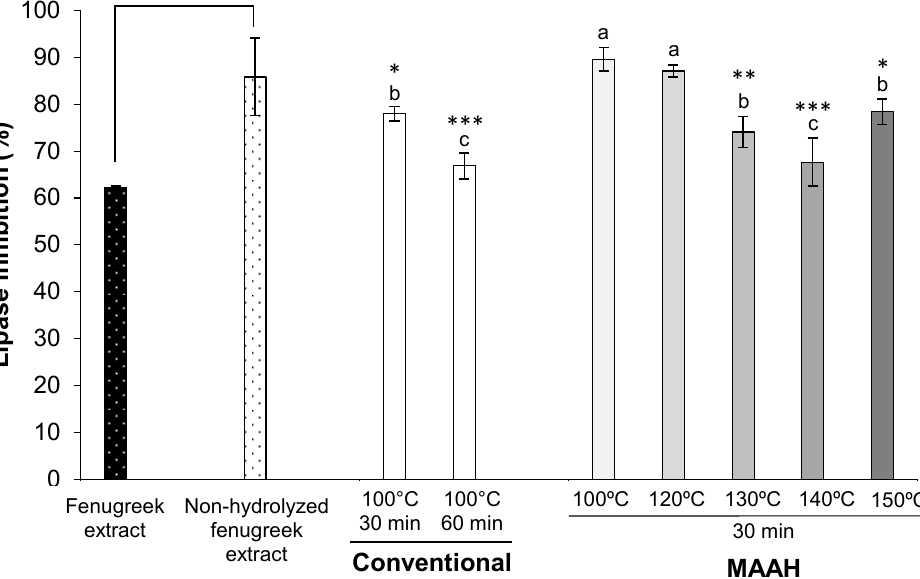
Figure 5. Effect of temperature on the pancreatic lipase inhibition (%) of fenugreek extracts and sapogenin-rich extracts obtained by conventional hydrolysis and microwave-assisted acid hydrolysis (MAAH). Standard deviations are indicated by error bars. Mean values with different letters are significantly different ( p ≤ 0.05) and mean values are significantly different from the non-hydrolyzed fenugreek extract if p ≤ 0.05 (*), p ≤ 0.01 (**) and p ≤ 0.001 (***). Non-hydrolyzed fenugreek extract is different from fenugreek extract (#, p ≤ 0.001). “Fenugreek extract” refers to the commercial saponin mixture as received from the supplier. “Non-hydrolyzed fenugreek extract” refers to the “fenugreek extract” extracted with ethyl acetate at time 0 of